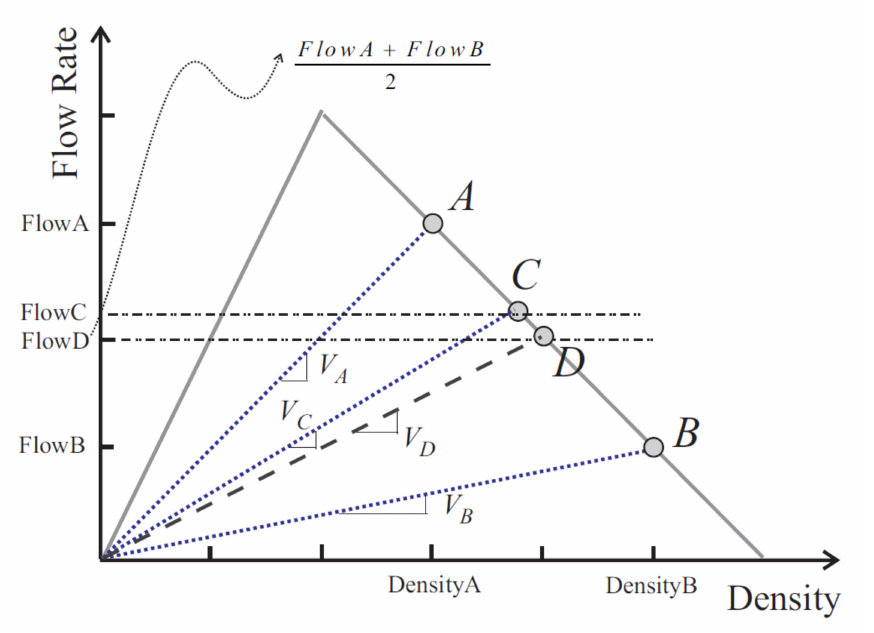
Figure 5. Analytical speed parameter